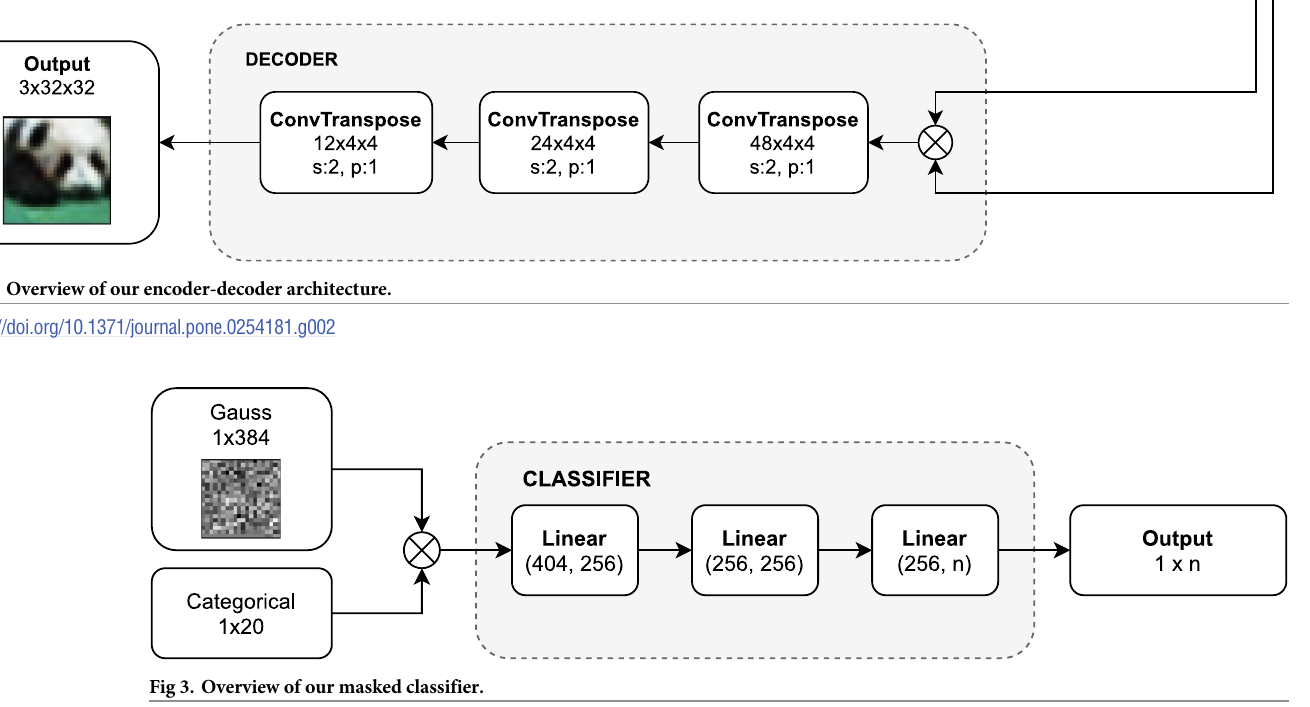
Fig 3. Overview of our masked